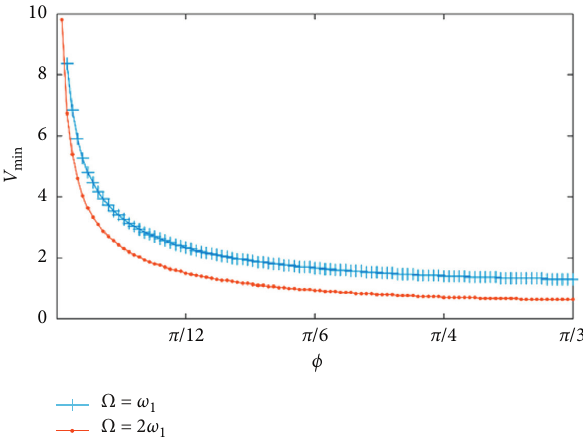
Figure 5: The minimum voltage value of unstable region changes with ϕ